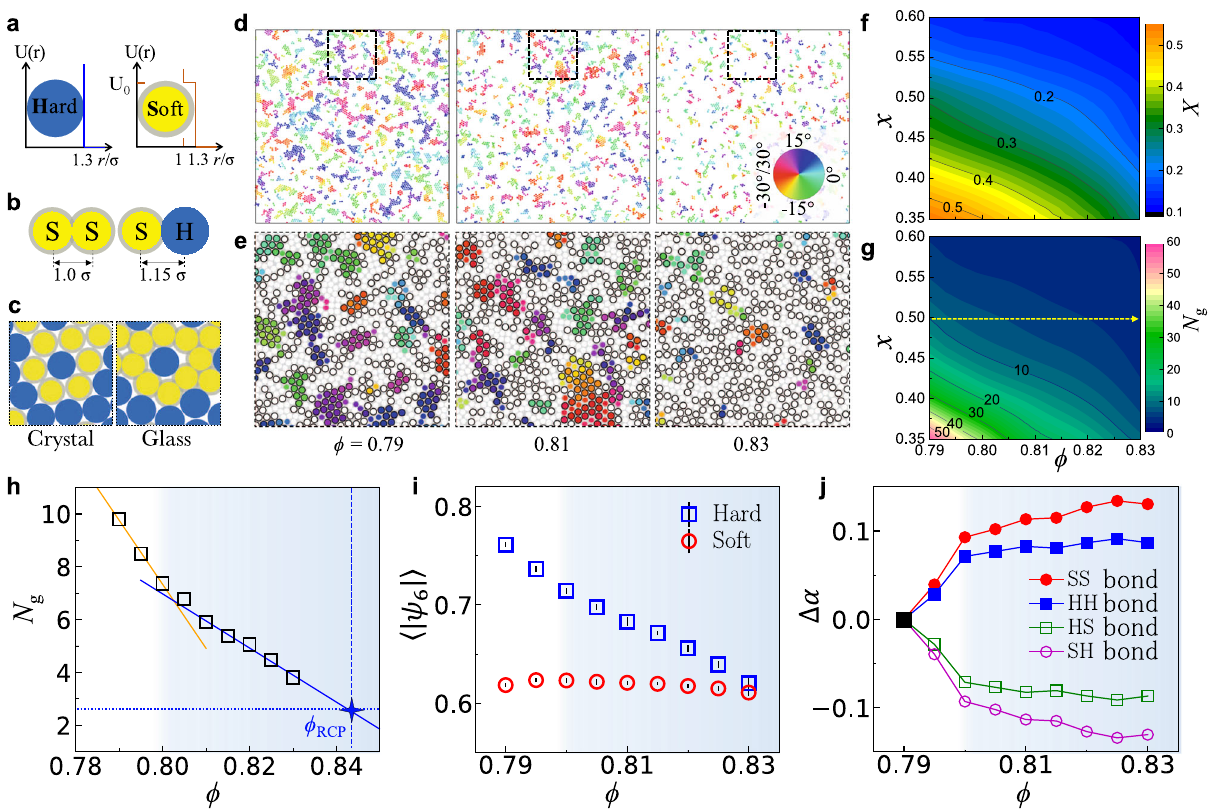
Fig. 2 Compression reduces the grain size in the glass-crystal composites (GCCs). a The interaction potentials for hard and soft particles. Soft particle has a square-shoulder potential with an outer diameter of 1.3 and inner hardcore diameter of 1. b Compressed bonds between soft – soft (SS) and soft – hard (SH) particles. c Example local packing structures for crystal (packing fraction ϕ = 0.65) and glass ( ϕ = 0.82) without and with compressed bonds, respectively. d GCCs at different ϕ and mixing ratio x = 0.5. Each crystalline particle is coloured according to its angle of the bond-orientational order parameter ψ 6 as shown by the colour wheel. Disordered particles are in white. e The enlarged views of the dash-boxed regions in d . Crystallites (as coloured in d ) are primarily composed of hard particles (black-rim circles). f , g The contour plots of crystallinity X and grain size N g in the ϕ – x plane, respectively. Their colour bars are shown in the right. Three structural quantities at x = 0.5 are shown in ( h – j ). h N g decreases with ϕ . N g ≈ 3 when ϕ is extrapolated to the random close-packing density ϕ RCP = 0.842 for binary-disk systems 66 . i 〈 ∣ ψ 6 ∣ 〉 averaged over hard and soft particles. j Δ α = α ( ϕ ) − α (0.79) for four types of bonds, which re fl ect particles' aggregation propensity (Eq. (1)). The changes in slope at ϕ = 0.80 in ( h , j ) correspond to a glass – glass transition (see Supplementary Note 2 for the